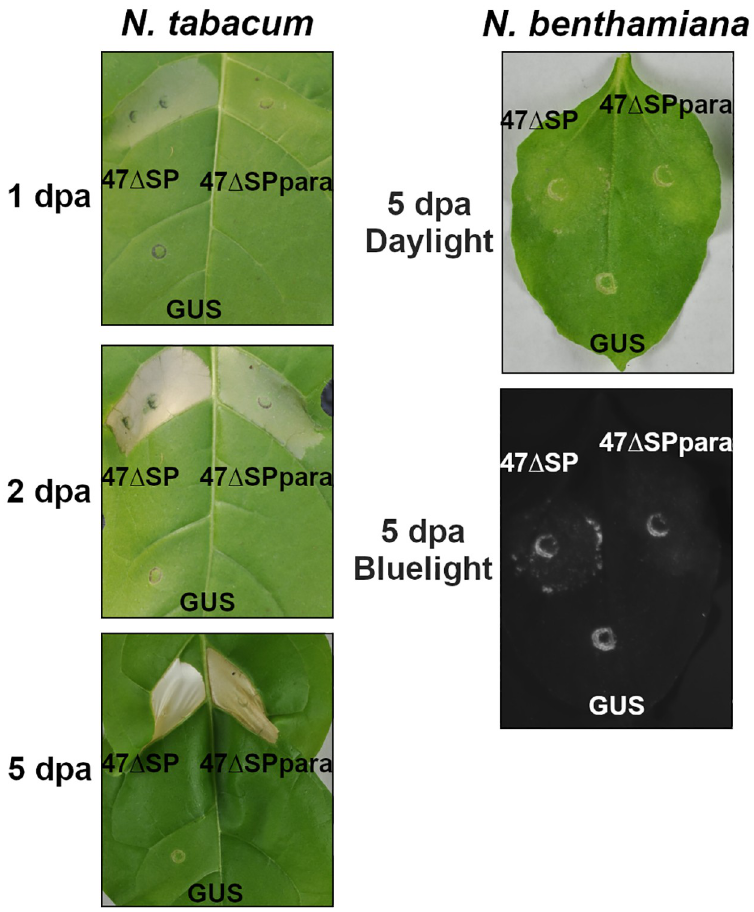
Fig 6. Ppar47 induces cell death in Nicotiana species. Cell death induction following Agrobacterium -mediated transient expression of Pvit47 Δ SP (47 Δ SP) and Ppar47 Δ SP (47 Δ SPpara) in leaves from N . tabacum (left) and N . benthamiana (right). Agrobacterium -mediated transient expression of GUS was used as negative control. Pictures were taken under daylight at 1, 2 and 5 days post-agroinfiltration (dpa) for N . tabacum and under daylight and blue light at 5 dpa for N . benthamiana . Results are representative of three independent